Question: Condense the content of this figure into a single sentence.
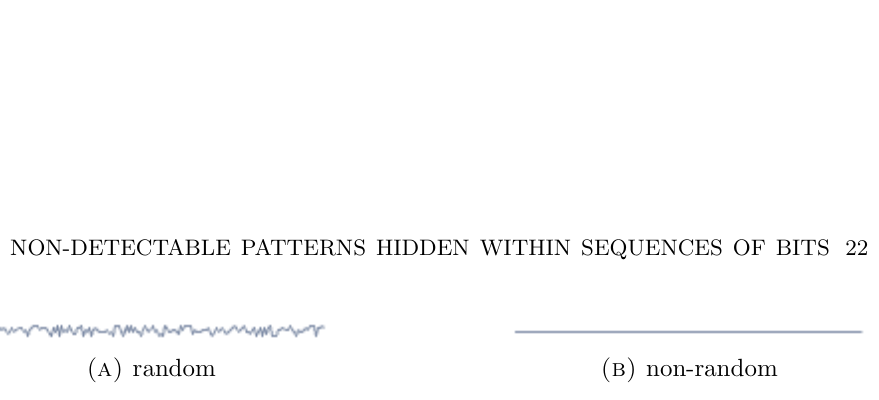
Answer: Sparklines showing the difference between expected NIST results if bit-stream is identified as ran- dom (left) vs non-random (right).